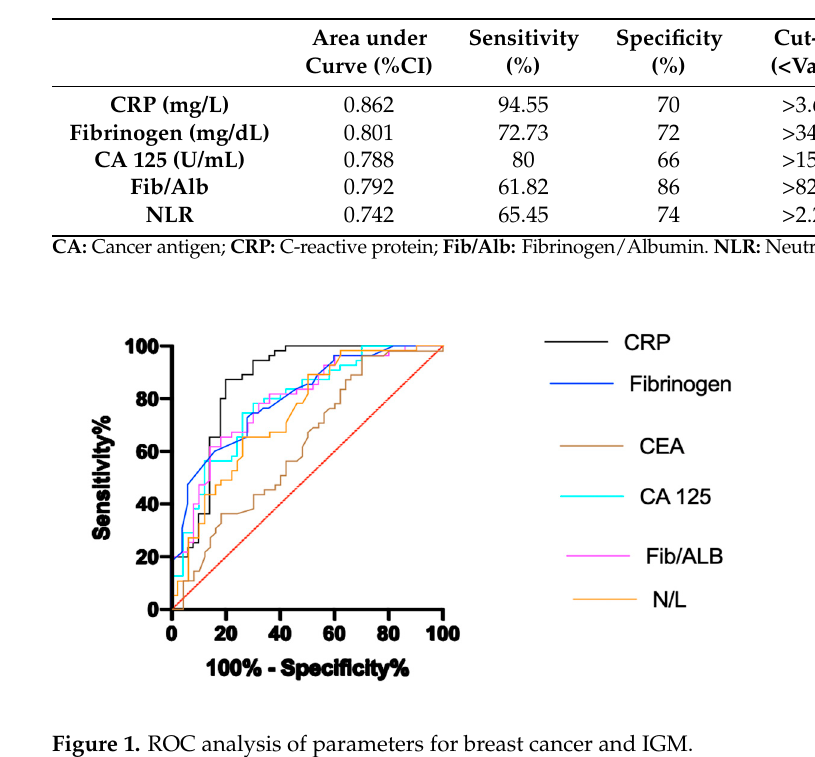
Table 5. Comparison of CRP, fibrinogen, CA125, Fib/Alb and NLR levels using ROC analysis for breast cancer and IGM groups.